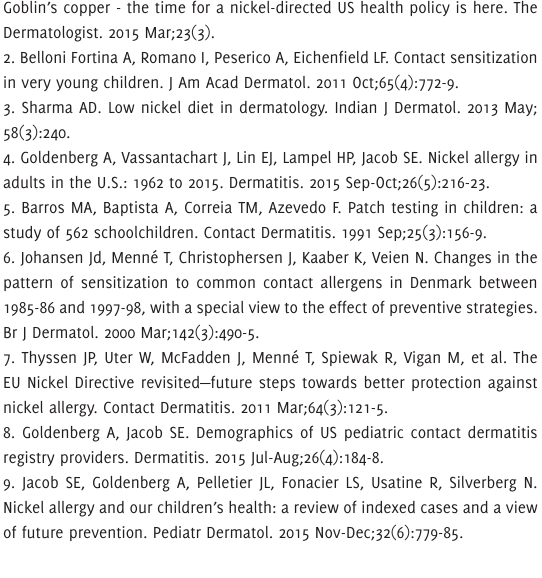
States with at least one nickel allergic contact dermatitis case reported in peer-reviewed literature are identified in Red (location based on affiliation of corresponding author, unless otherwise noted or confir- med). States with at least one confirmed case of nickel dermatitis, but no reported cases in peer-reviewed literature are identified in Pink. States for which there is insufficient data are identified in